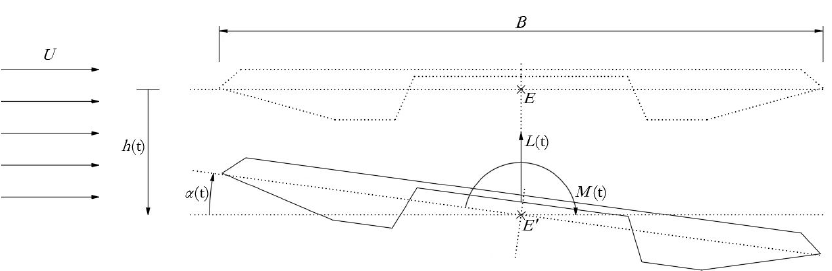
Figure 5. Schematic diagram of the pitching and heaving combined motion of the sectional model.